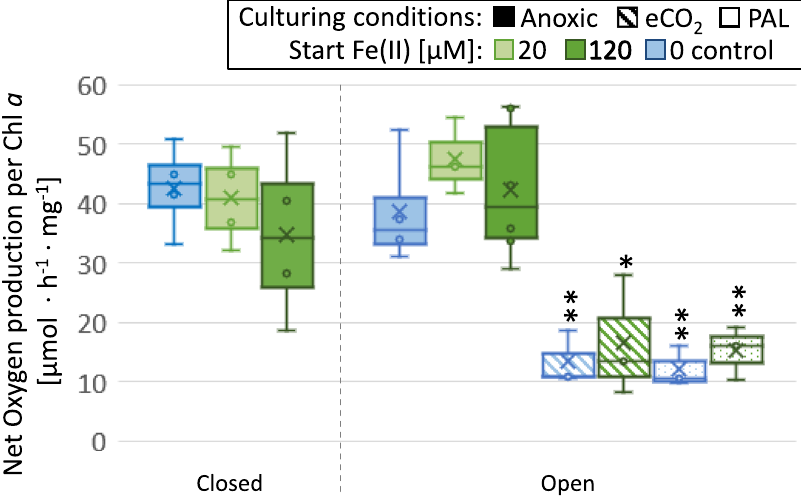
Fig. 5 Boxplot of the hourly net oxygen production rates of Pseudanabaena sp. PCC7367 per unit of cellular Chl a content when grown under different atmospheres. The anoxic atmospheres (solid colour) tested were either N 2 with 10% CO 2 (closed, left) or 0.2% CO 2 (open, right). The different Fe(II) starting concentrations were 20 µ M Fe(II) (light green), 120 µ M Fe(II) (dark green) or none for the control (blue). The control atmospheres were ambient air either with the present-day atmospheric levels of CO 2 (PAL, dotted) or supplemented with 0.2% CO 2 (eCO 2 , striped). Oxygen production was determined by measuring the oxygen accumulation in 8-day old cultures (open system and ambient air) and in 5-day old cultures (closed system) with an oxygen sensor in a cuvette and piercing oxygen needle sensor in the closed growth vessel, respectively. The light intensity during the measurement was set at the growth light intensity of 25 PPFD. Asterisks (*) represent a signi fi cant difference to the open anoxic system under the same light intensity (* p < 0.05; ** p < 0.01; Student ’ s t -test, two-tailed). In the boxplot, the cross indicates the mean, the centre line shows the median value and the bounds of the box indicate the 75 th and 25 th percentiles, calculated with inclusive median, while the whiskers represent the furthest minimum and maximum measurement outliers. n = 4 (anoxic, closed), n = 3 (PAL and eCO 2 ). The anoxic, open measurements ( n = 6) had data excluded from the control and 20 µ M Fe(II), which had no O 2 production, resulting in n = 4 (control) and n = 3 (20 µ M Fe(II)). All measurements were performed on biologically independent